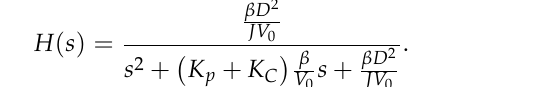
Figure 3. Hydraulically actuated stabilization system design [13] .